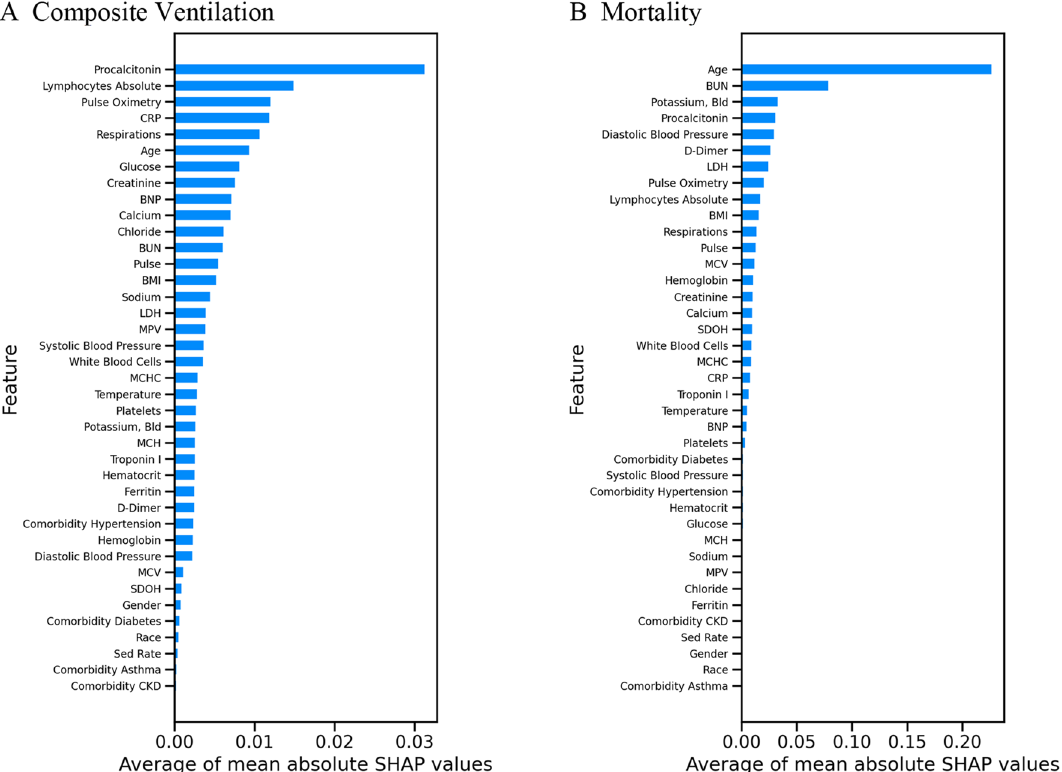
Figure 4. Feature importance of a trained XGBoost model. The higher the absolute SHAP value, the greater the contribution of the feature to the predicted outcome. The SHAP values are averaged over 5 folds of test splits that span the whole dataset. ( A ) The top three most important features for predicting ventilation are Procalcitonin, Lymphocytes Absolute and Pulse Oximetry. ( B ) The top three most important features for predicting mortality are Age, BUN and